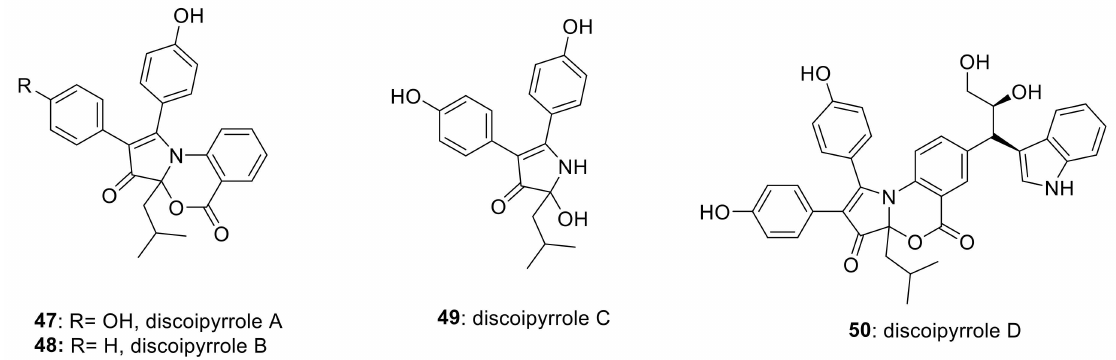
Figure 20. Chemical structures of natural alkaloids discoipyrroles A–D ( 47 – 50 ). Reprinted with permission from Ref. [153].